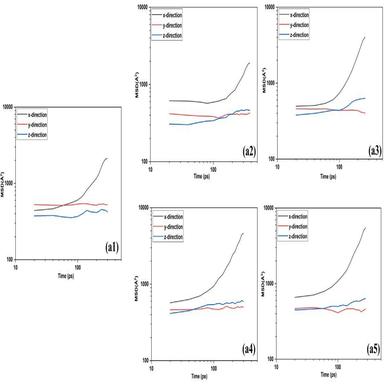
MSD components plotted separately for the , and -directions from (a1) to (a5) for P to P-3D, respectively.